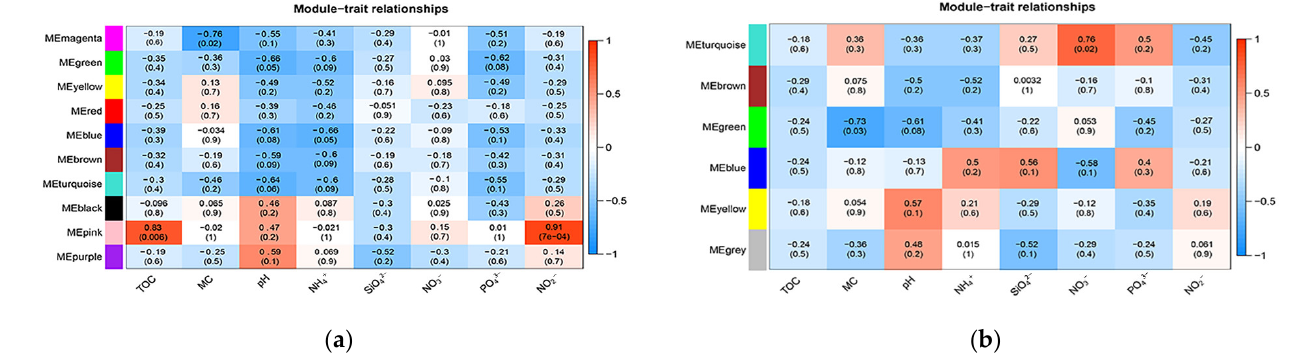
Figure 6. Module–geochemical property relationships of bacteria ( a ) and archaea ( b ). The abscissa is the geochemical properties, and the ordinate is the modules. The red squares show a positive correlation, and the green ones show a negative correlation. The darker the color, the stronger the correlation.